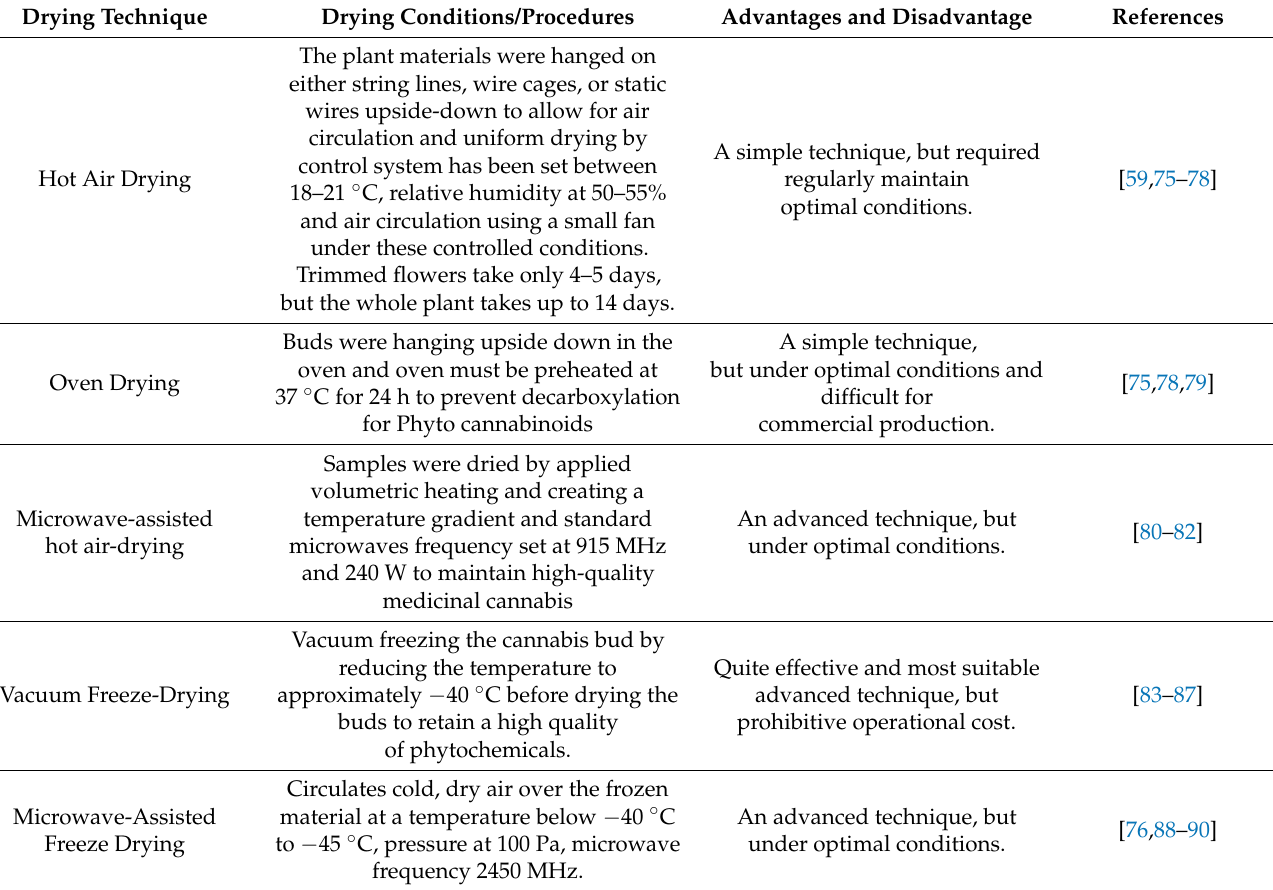
Table 1. Drying techniques for medicinal Cannabis